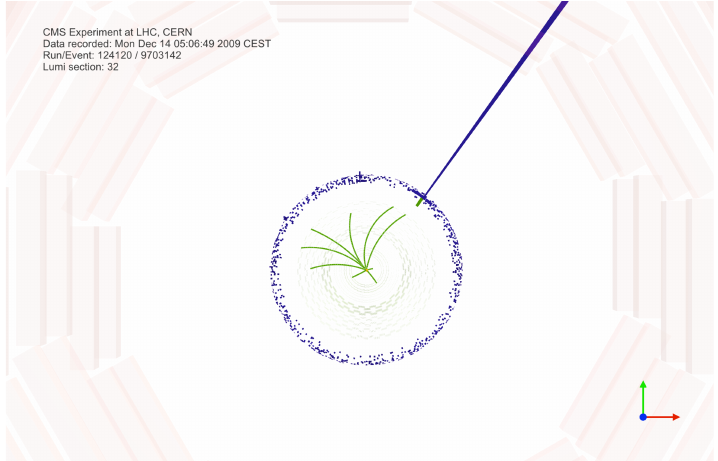
Figure 6. Event display showing a spike signal where a large amount of energy is deposited in a single ECAL readout channel. Tracks are shown in green and the energy deposited in the ECAL is shown in blue, with the spike event at approximately 1 o’clock.